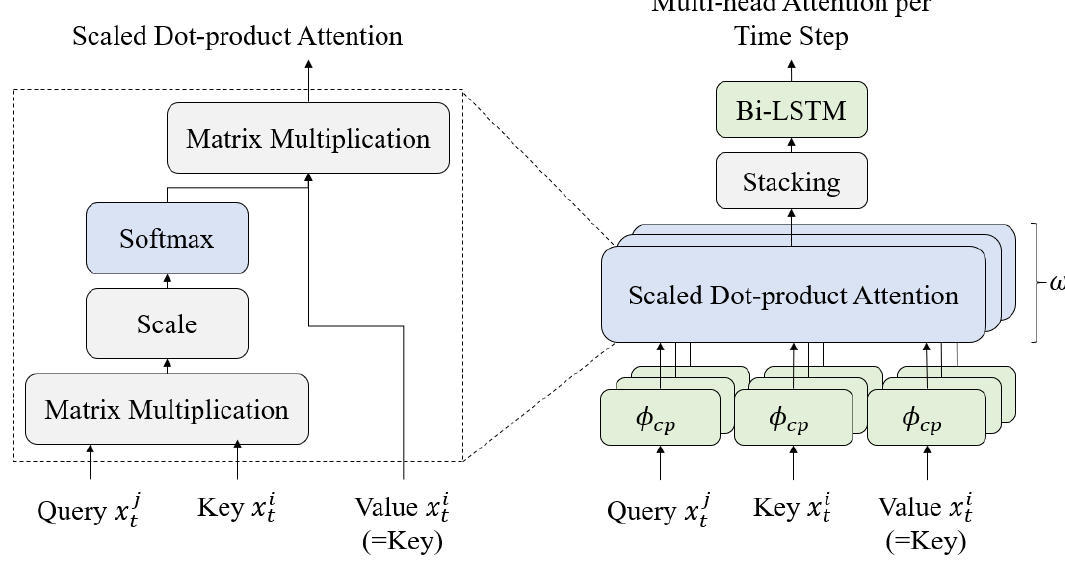
Figure 4. The operations of the multi-headed attention.